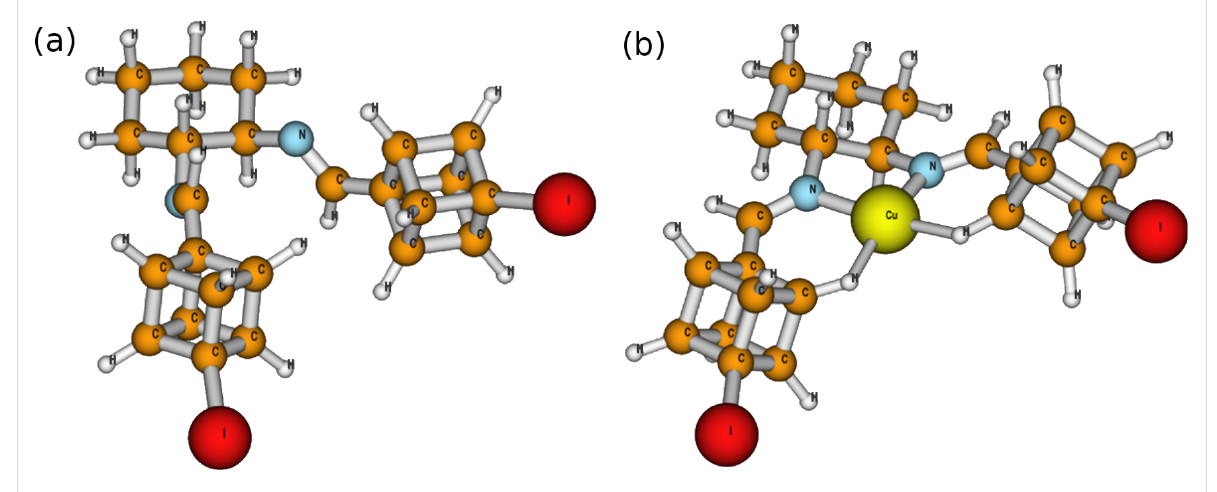
Figure 2: M06L DFT global minima for (a) (1 R ,2 R )- N , N ’-bis[(4-iodocuban-1-yl)methylene]- trans -1,2-diaminocyclohexane ( 1 ) and (b) Cu +1 complex with ligand 1 .